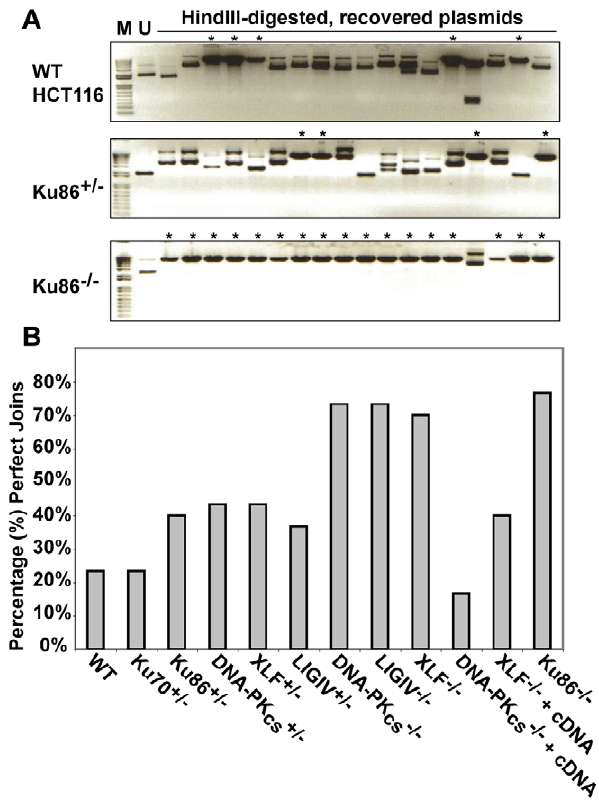
Figure 5. The absence of Ku86 results in predominately microhomology-based end joining. (A) HindIII -linearized pEGFP- Pem1-Ad2 plasmids were recovered from either WT HCT116, Ku86 + / 2 or Ku86 2 / 2 cells, propagated through E. coli and then analyzed for retention of a single HindIII restriction site (‘‘perfect rejoining’’) by HindIII restriction enzyme digestion analysis. The asterisks indicate those plasmids where perfect rejoining occurred. (B) The results of four or more experiments similar to those depicted in (A) were combined and summarized. N.B . The re-expression of a WT DNA-PK cs or XLF cDNA ( + cDNA) in their respective null cell lines reduced the frequency of perfect rejoining back to WT levels, confirming the specificity of the